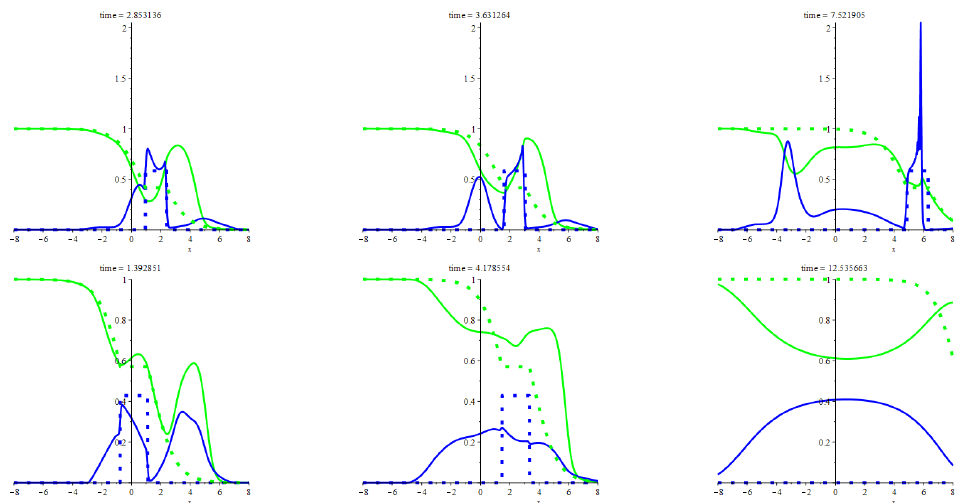
Figure 5. The figure illustrates two ways of evolution of a heavily perturbed patchy wave. The per- turbation is smoothly localized ahead from the patch and got moving instantly towards the patch. The meaning of the colors and styles of lines is the same as for Figure 3. The detailed description of the initial states and other settings used for computing this figure are in Appendix